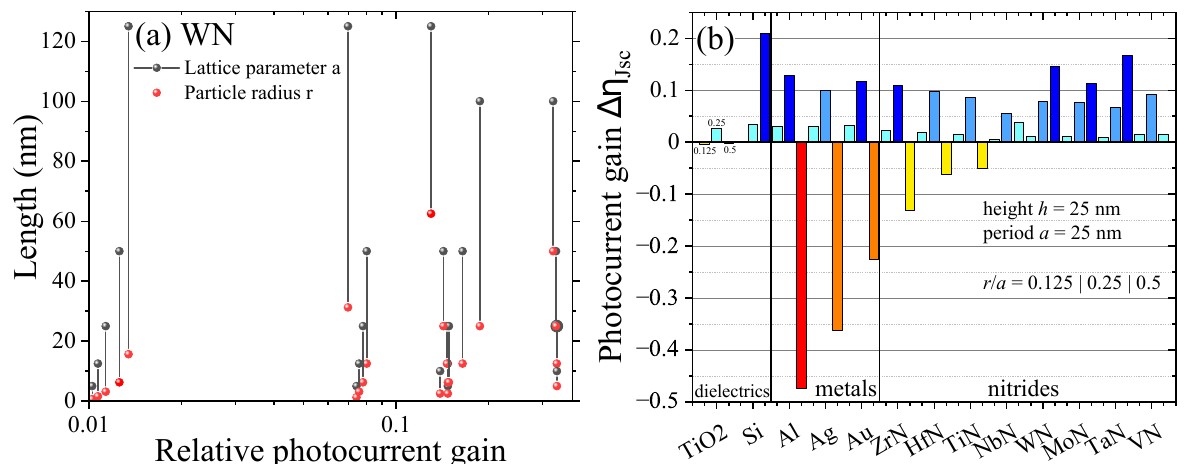
Figure 5. Relative photocurrent gain for an n-doped Si solar cell with particle layers of different materials. ( a ) For WN as a representative of the class of nitrides, the relative photocurrent gain ∆ η is given for a range of geometrical parameters. The data pairs show the lattice parameter a together with the radius r of the WN disks at heights h = 25 and h = 50 nm. ( b ) Comparing the different material classes for three geometrical setups with varying r / a -ratio showing r / a = 0.125 , r / a = 0.25 , and r / a = 0.5 side-by-side for each